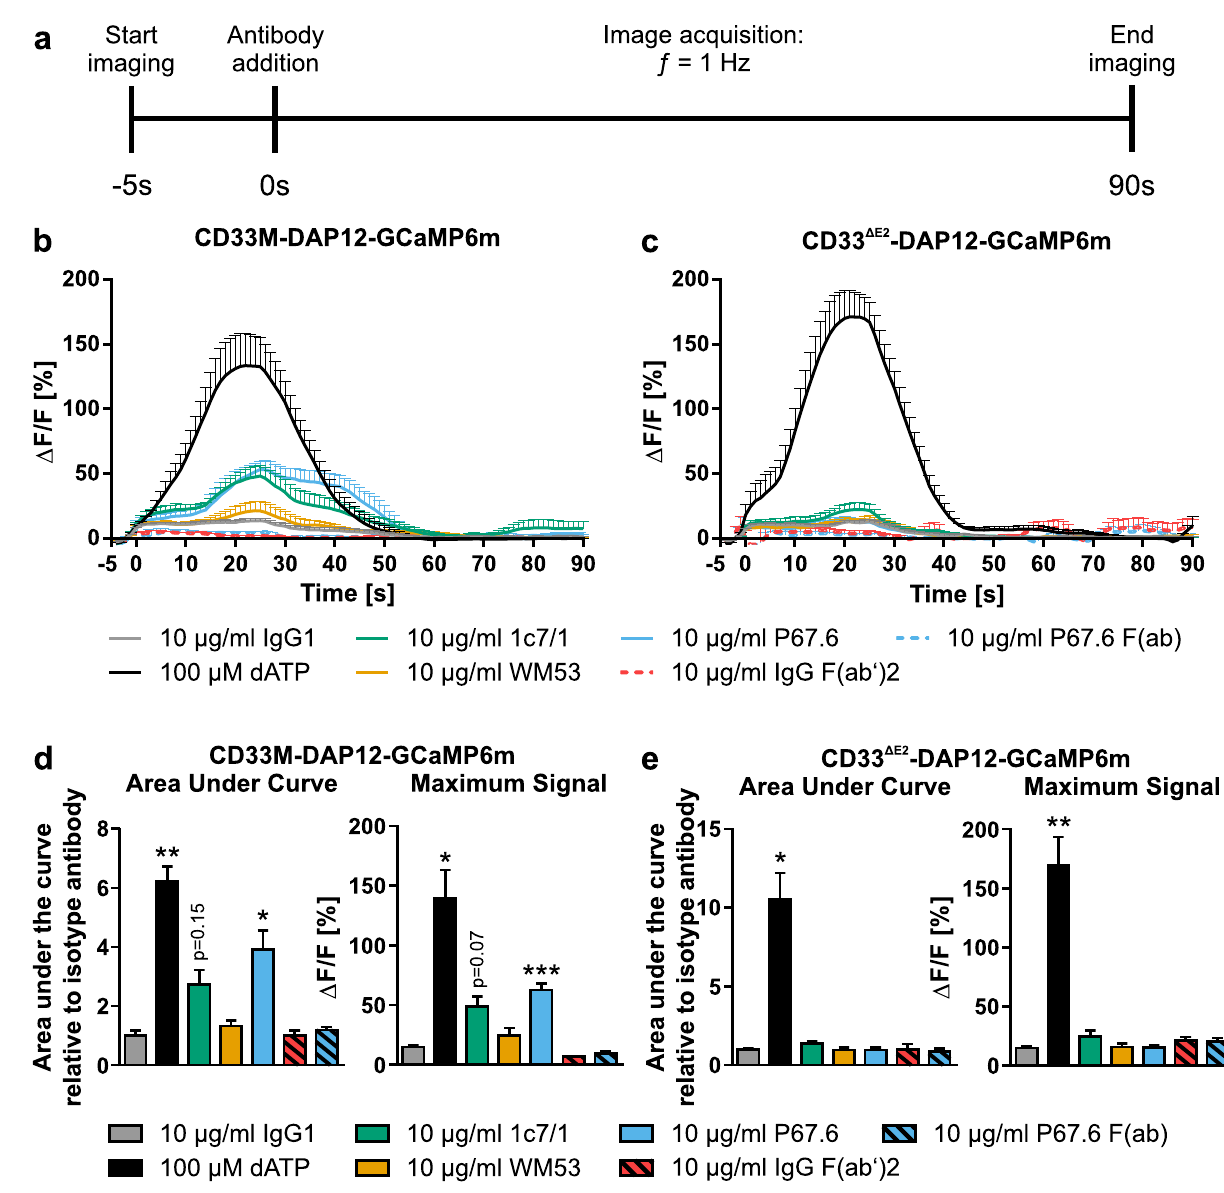
Figure 4. Calcium imaging in CD33-DAP12-GCaMP6m reporter cell lines. ( a ) Schematic time line of image acquisition and compound handling. ( b , c ) Calcium imaging analyzed as ΔF/F(t) in CD33-DAP12-GCaMP6m lines. Addition 100 µM dATP led to a strong increase in intracellular calcium levels in both cell lines, CD33M- and CD33 ∆E2 -DAP12-GCaMP6m, with a peak at around 20–25 s. The CD33 antibody clones 1c7/1 and P67.6 evoked a selective intracellular calcium response only in CD33M-DAP12-GCaMP6m cells. The CD33 antibody clones WM53 and P67.6 F(ab) as well as the isotype IgG1/F(ab’)2 antibodies did not show a change in intracellular calcium levels. ( d , e ) The area under the curve as well as the maximum ΔF/F(t) signal calculated from independent experiments showed a significant increase in dATP treated samples in both CD33-DAP12- GCaMP6m lines and a selective increase in CD33M-DAP12-GCaMP6m expressing cells if treated with the CD33 antibody clone P67.6 or 1c7/1. Data are presented mean + SEM; n = 3–6; *** p ≤ 0.001, ** p ≤ 0.01, * p ≤ 0.05 compared to 10 µg/ml IgG1 determined by Welch ANOVA followed by Games-Howell post hoc test.